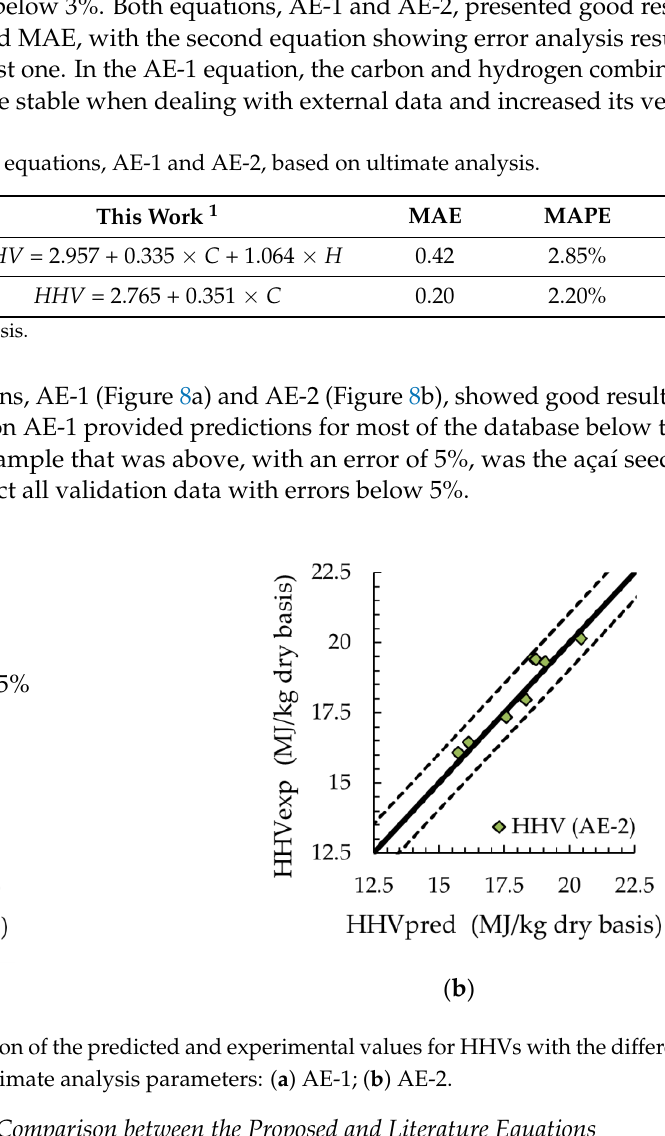
Table 11. Error table for equations based on proximate analysis.